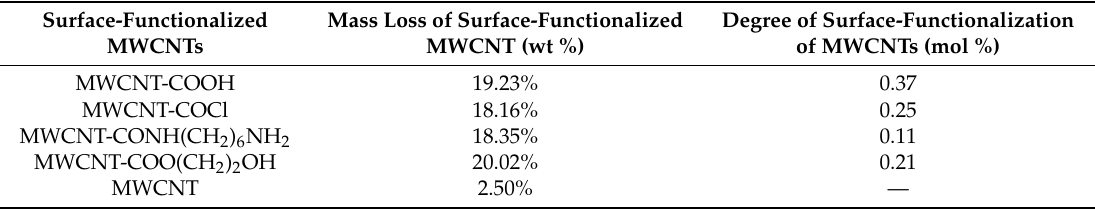
Table 1. Degree of surface-functionalization of MWCNTs.